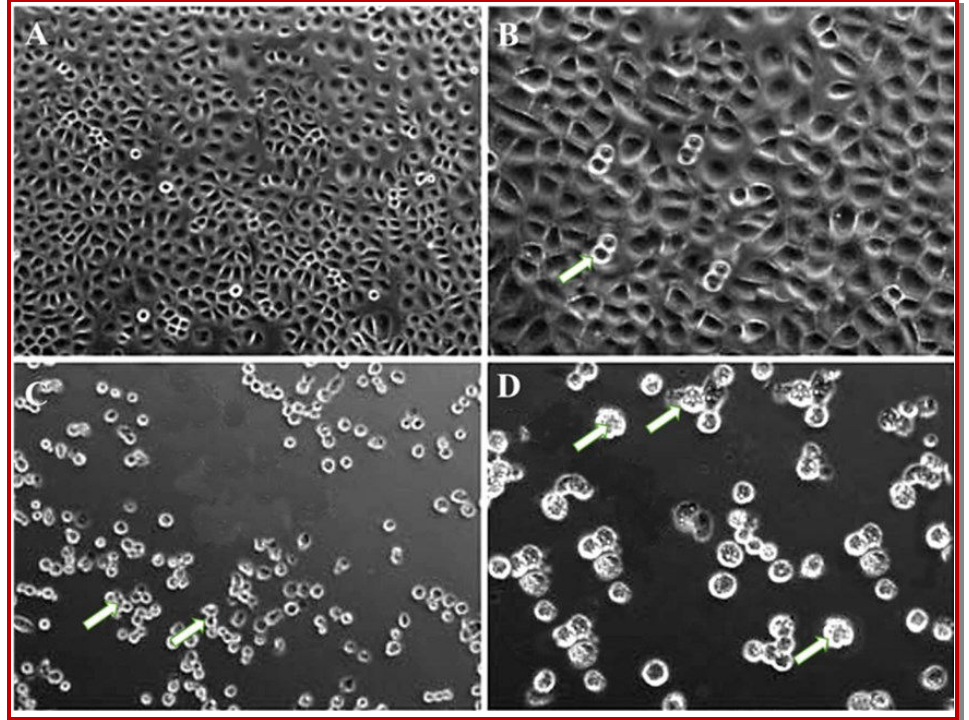
Figure 3: Phase contrast microscopic evaluation of the effect of lactucin on the morphology of HL-60 human leukemia cancer cells. The cells were treated without (A) and with 5 (B), 50 (C) and 100 (D) Μ m of lactucin for 48 hours. The untreated control cells ad- here well, exhibiting normal morphology